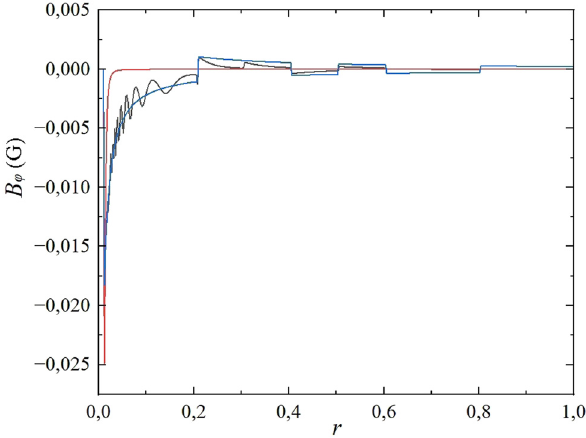
Figure 1: Magnetic fi eld for random initial conditions. Red line shows = t 10 s, 5 black line – = t 10 s, 6 blue line = t 10 s.